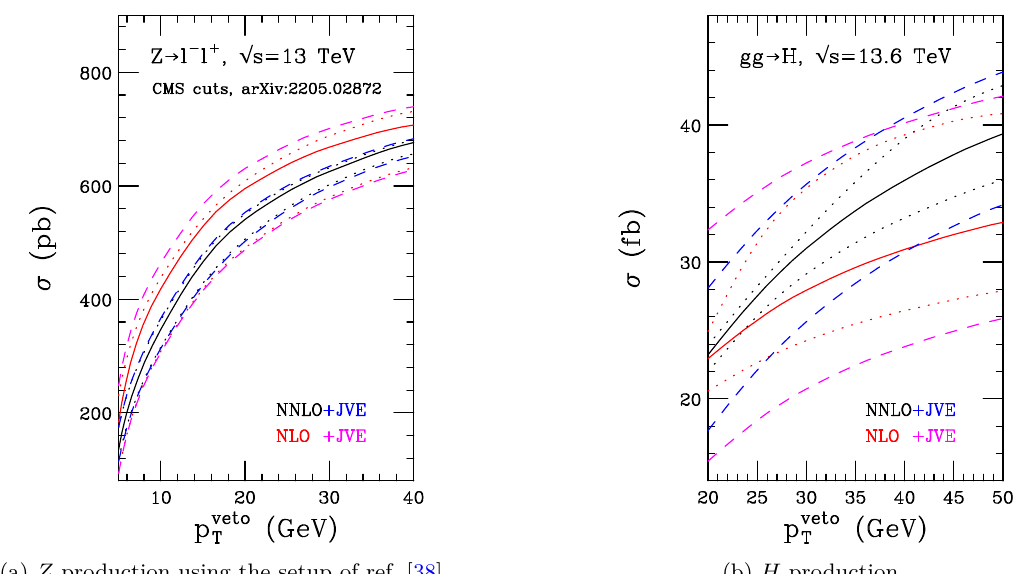
Figure 3 . Comparison of NLO and NNLO fixed order predictions as a function of the jet veto. Central predictions solid, uncertainty estimates using either the two-scale approach (dotted) or the envelope of that and the JVE approach (dashed).